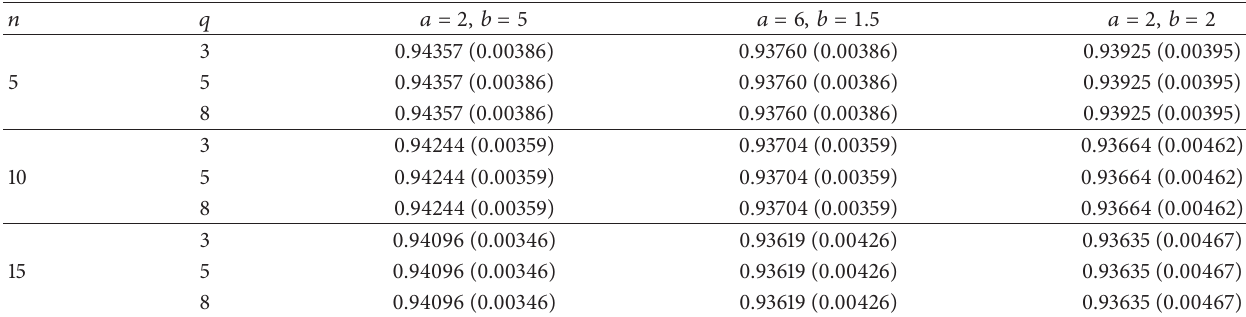
Table 5: Average empirical credible level (1 − 𝛼) for 𝐶 𝐿 under GE loss function when 𝛼 = 0.05